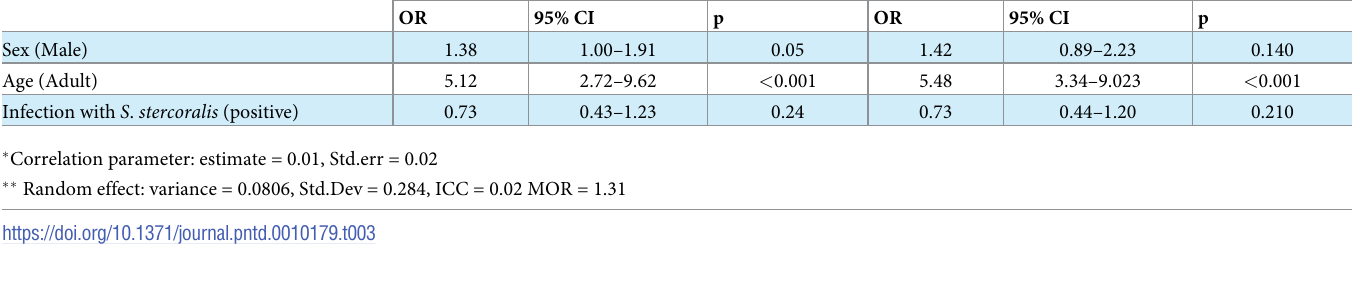
Table 3. Marginal and multilevel logistic regression that describes associations between T . cruzi infection and age, sex, and infection with S . stercoralis . Variable